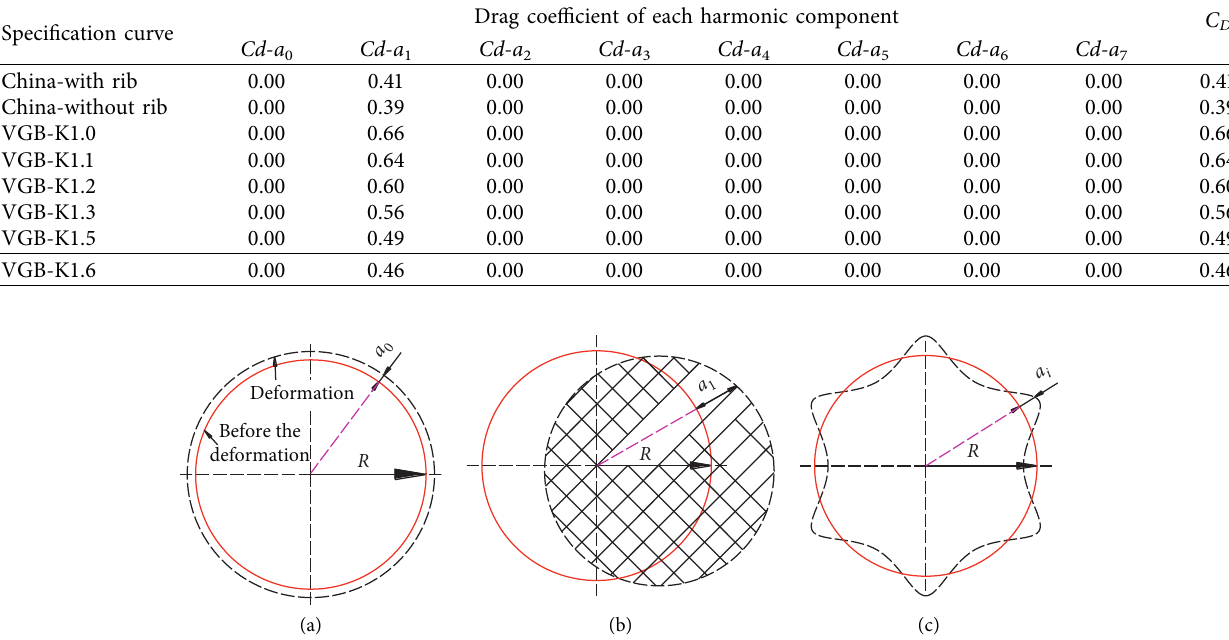
Table 4: Cd of each harmonic component.